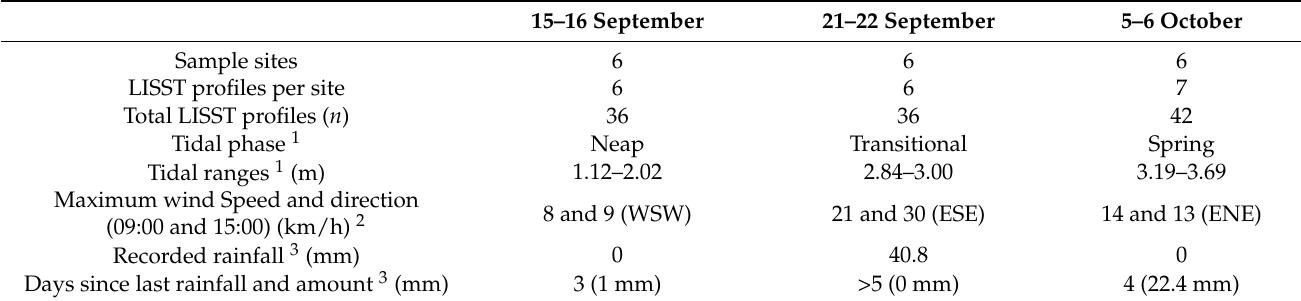
Table 1. Meteorological and hydrodynamic conditions in the Port Curtis estuary during the survey days in